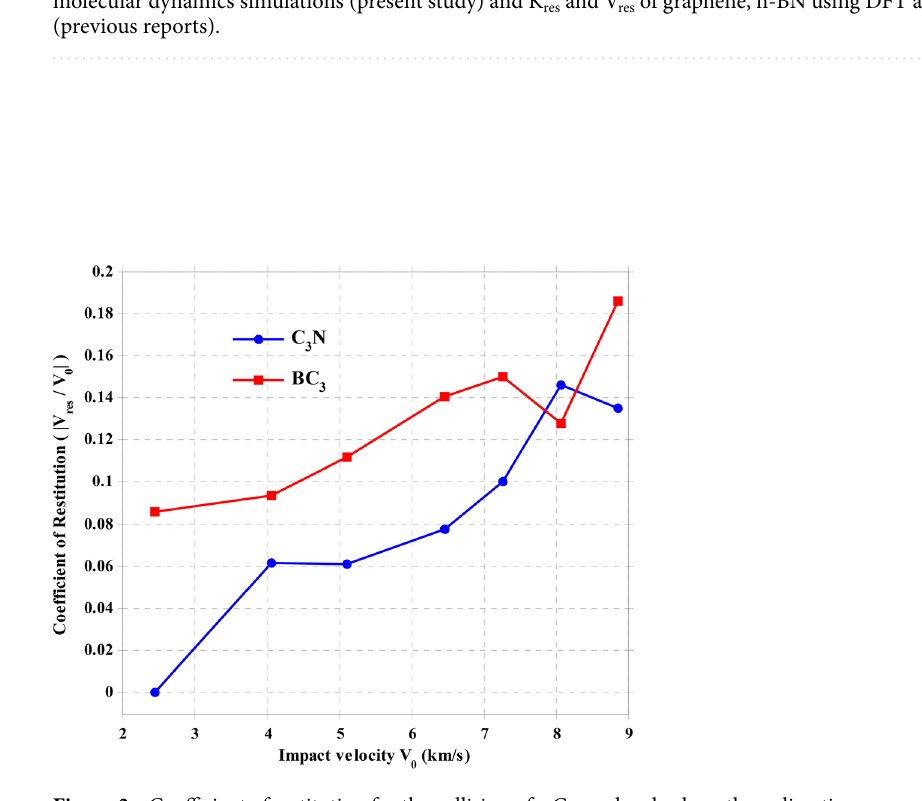
Figure 3. Coefficient of restitution for the collision of a C 60 molecule along the